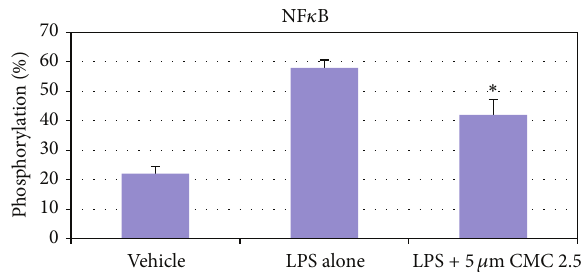
Figure 6: Inhibition of NF 𝜅 B phosphorylation by CMC 2.5 in PBMC cells. PBMC cells (5 × 10 4 cells/well) were cultured in serum- free media (37 ∘ C, 95% air, 5% CO 2 ) for 18 hours with LPS ( P. gingivalis , 50 ng/mL) or vehicle alone. CMC 2.5 was added at a final concentration of 5 𝜇 M. Following the incubation, cells were fixed and phosphorylation of NF 𝜅 B was analyzed by CASE cellular activation of signaling ELISA kit. ∗ 𝑃 ≤ 0.05 .